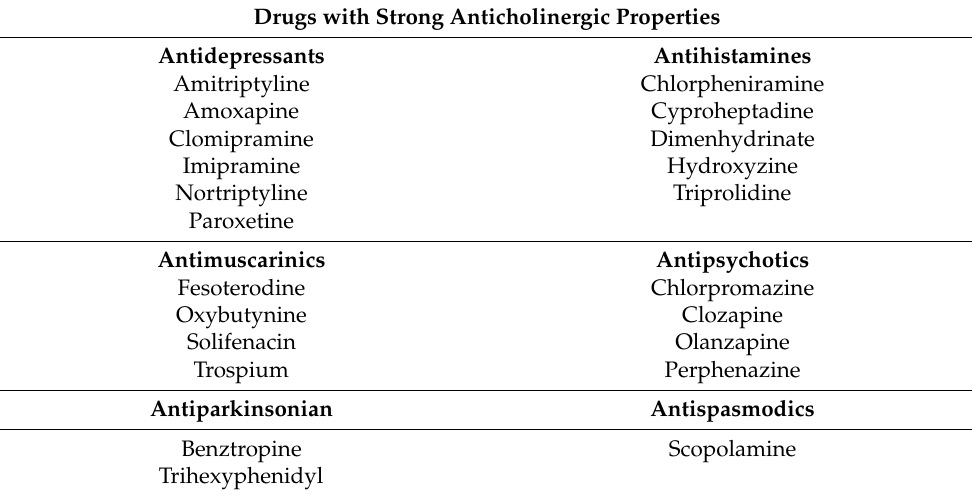
Table 1. List of potentially inappropriate medications in elderly patients with dementia (DPIMs) based on the institutional formulary according to the 2015 Beers